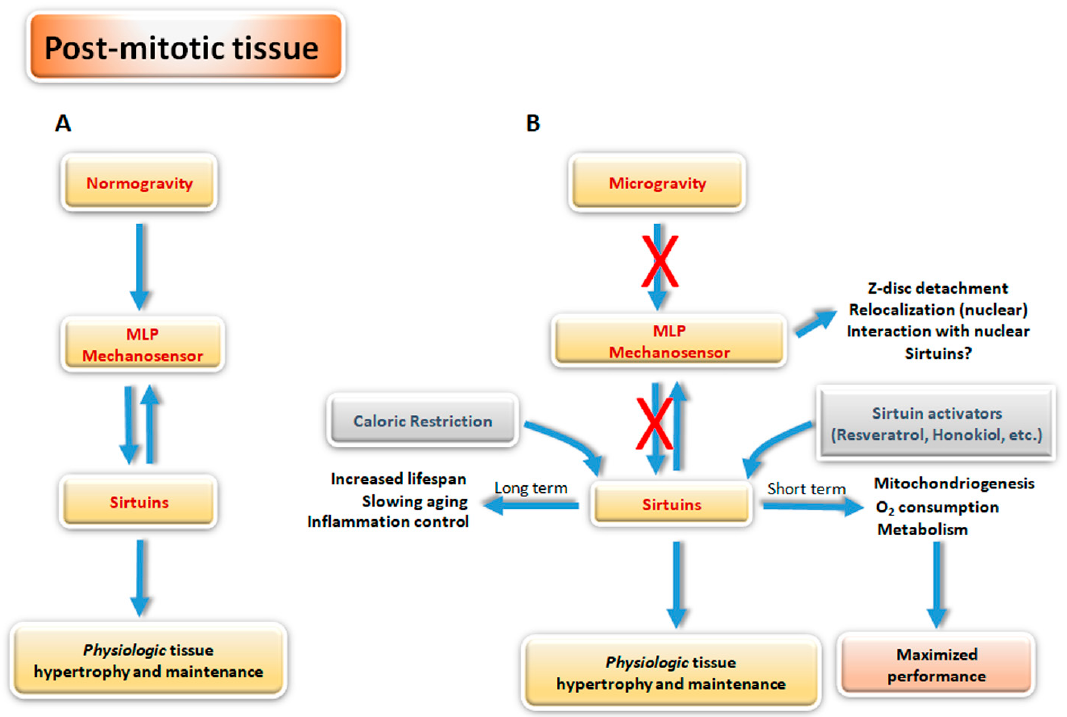
Figure 2. Schematic representation of the possible interaction in post-mitotic cells between the mechanosensor muscle LIM protein (MLP) and sirtuins in normogravity ( A ) and microgravity ( B